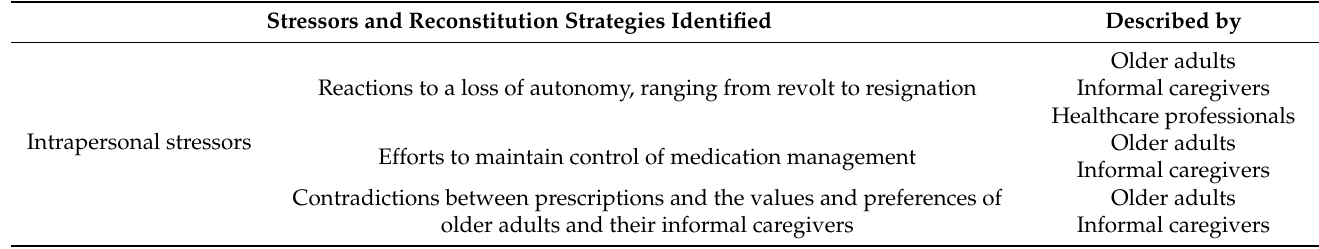
Table 4. Contributions to identifying and describing stressors and reconstitution strategies made by each participant group. Stressors and Reconstitution Strategies